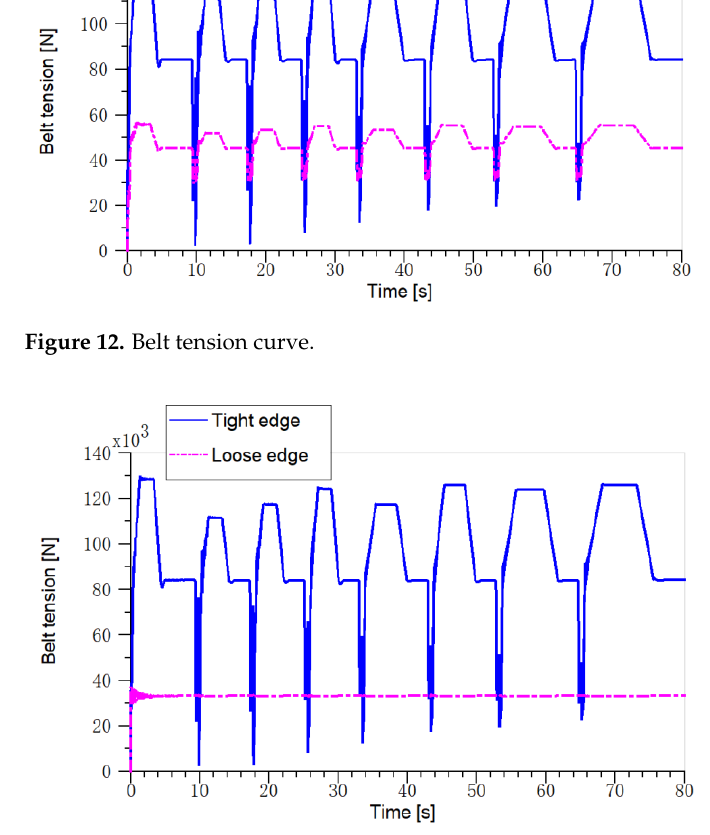
Figure 13. Belt tension curve of the driving pulley.